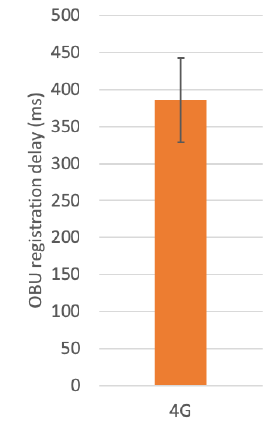
Figure 10. OBU registration